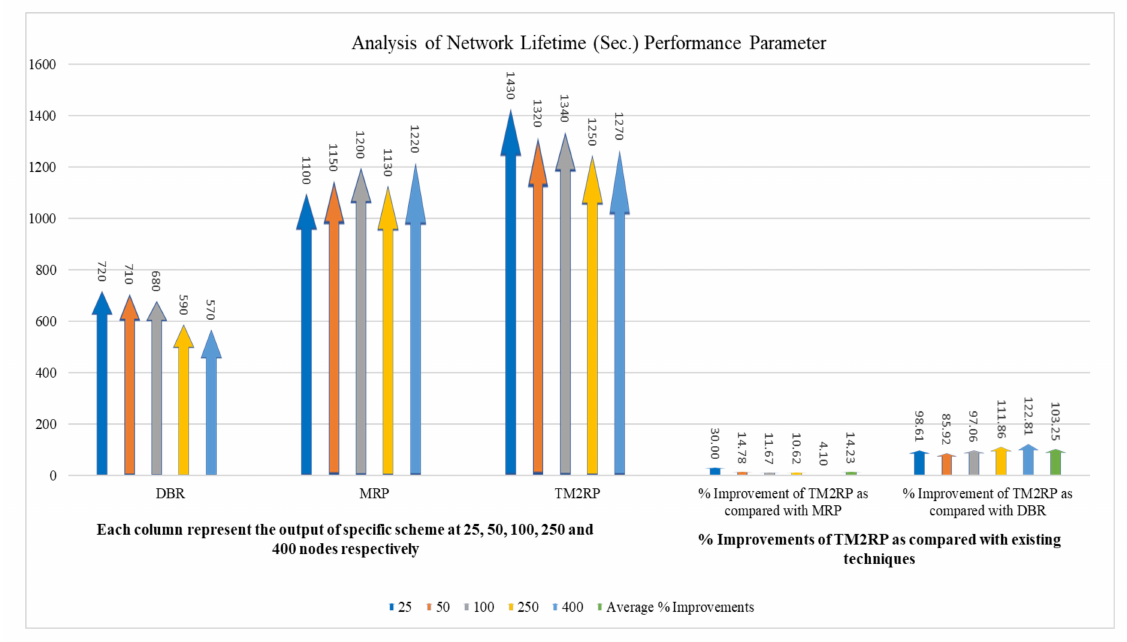
Figure 12. The statistical outcomes of the comparative protocols with regard to network lifetime.